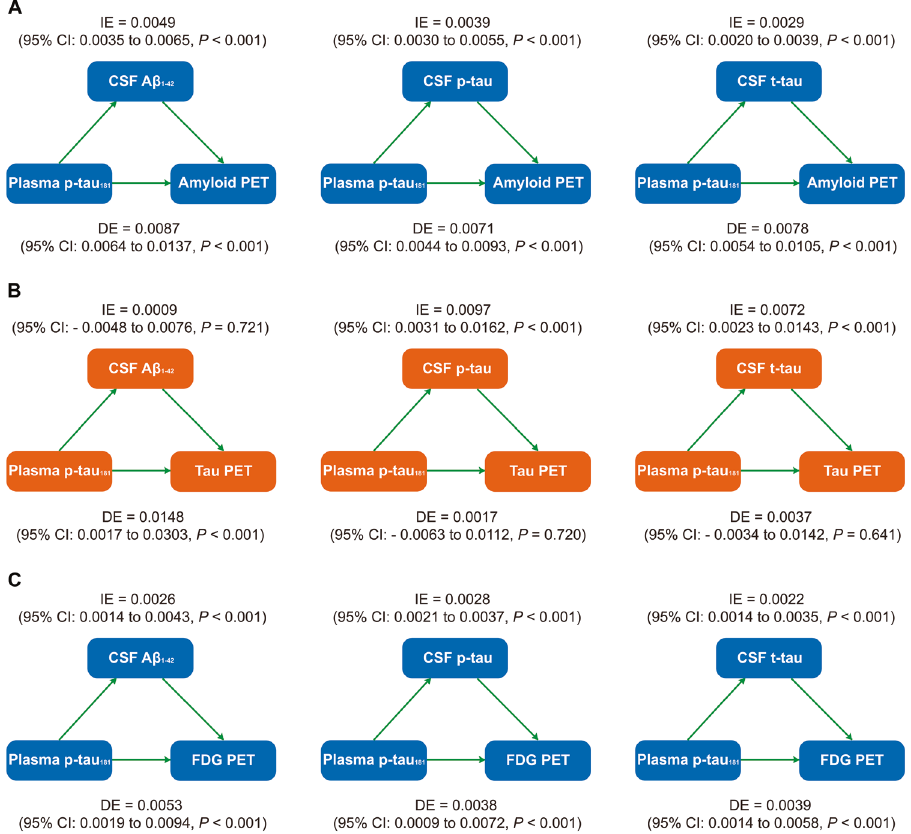
Fig. 3 Mediation analyses with brain PET uptakes as pathological outcomes. The relationships of plasma p-tau181 with brain amyloid PET uptake ( A ), tau PET uptake ( B ), and FDG PET uptake ( C ) were mediated by CSF biomarkers. IE indirect effect, DE direct effect.